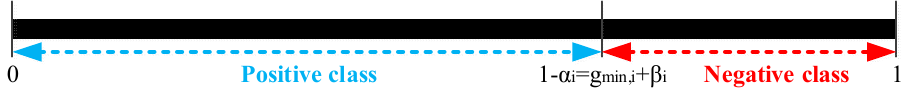
Figure 3. The appurtenance of energy systems to the positive or negative class.